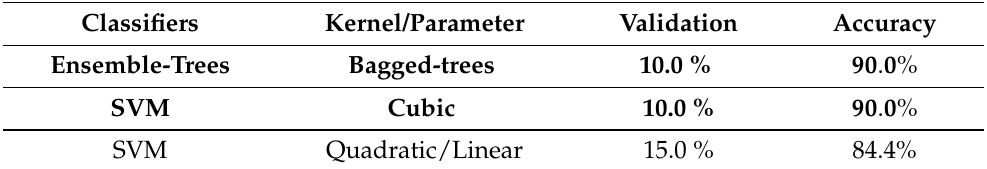
Table 15. The accuracy of classification of different classifiers of MAP-based experiment (300 subjects (balanced (150 normal, 150